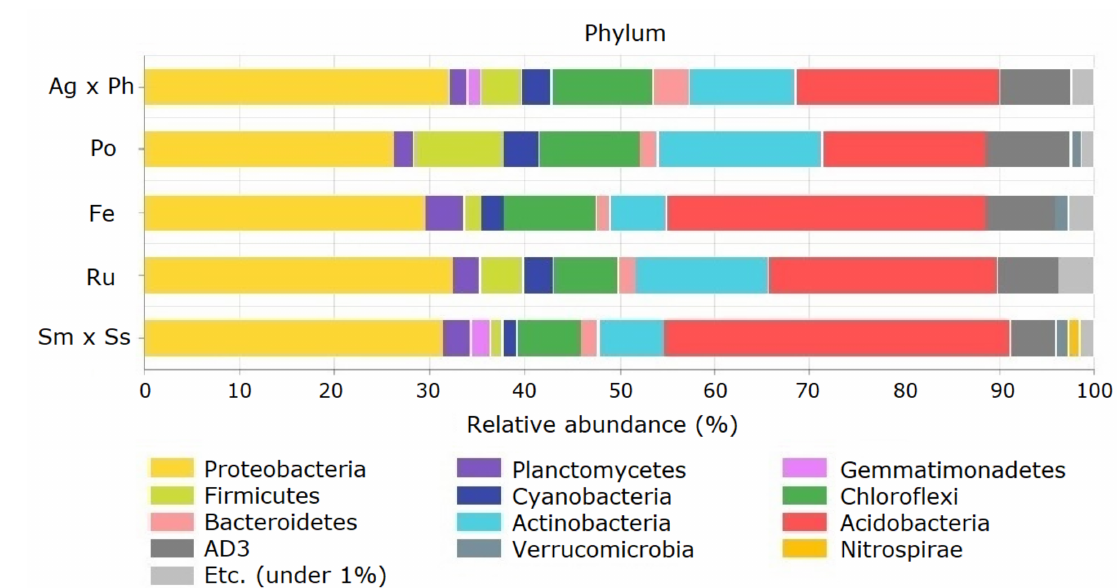
Figure 4. Relative abundance of soil bacteria at the phylum level in the pasture. Ag × Ph, A. alba × P. pratense ; Po, P. pratensis ; Fe, F. ovina ; Ru, R. acetosella ; Sm × Ss, S. miyabei × S. salicifolia .